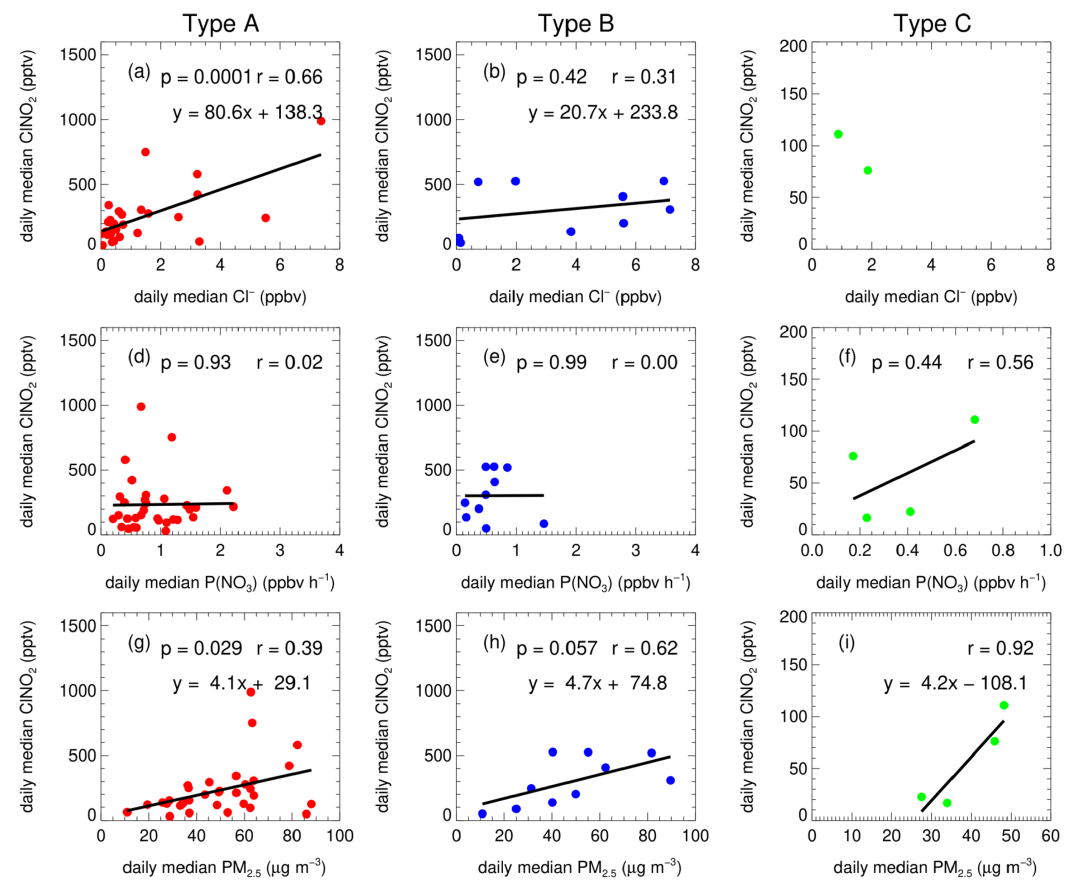
Figure 7. The functional dependence of the daily median of ClNO 2 on particulate chloride, nitrate radical production rate and PM 2 . 5 in the air mass of Type A (a, d, g) , Type B (b, e, h) , and Type C (c, f, i) .